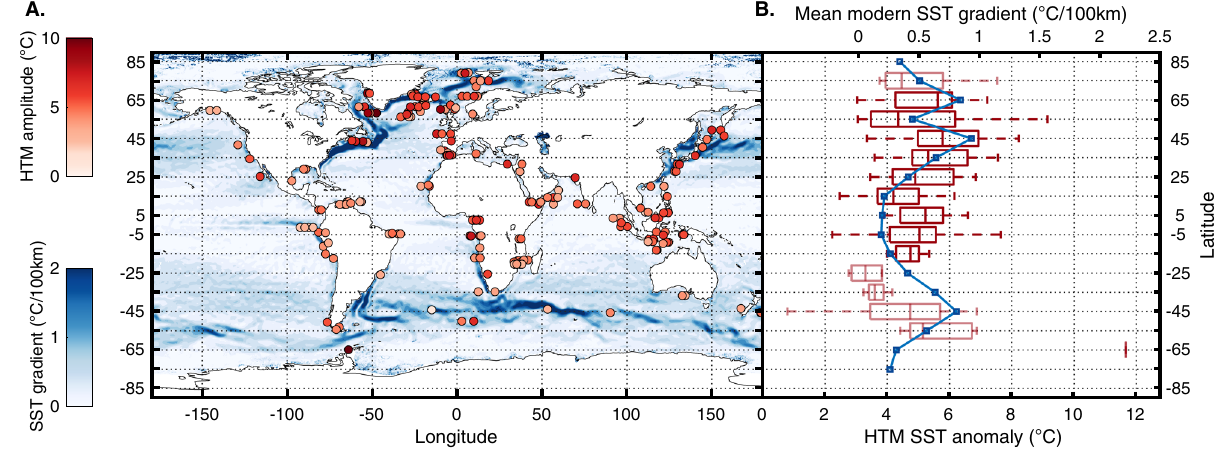
Fig. 2 | Latitudinal structure of the Holocene Thermal Maximum amplitude. A Meanseasurfacetemperature(SST)gradient 46 (de fi nedas g = k ∇ SST k ,calculated basedona0.25°resolutionmap)and medianmarineHTM anomalies comparedto mean Holocene (dots). B Marine Holocene Thermal Maximum anomalies (bottom